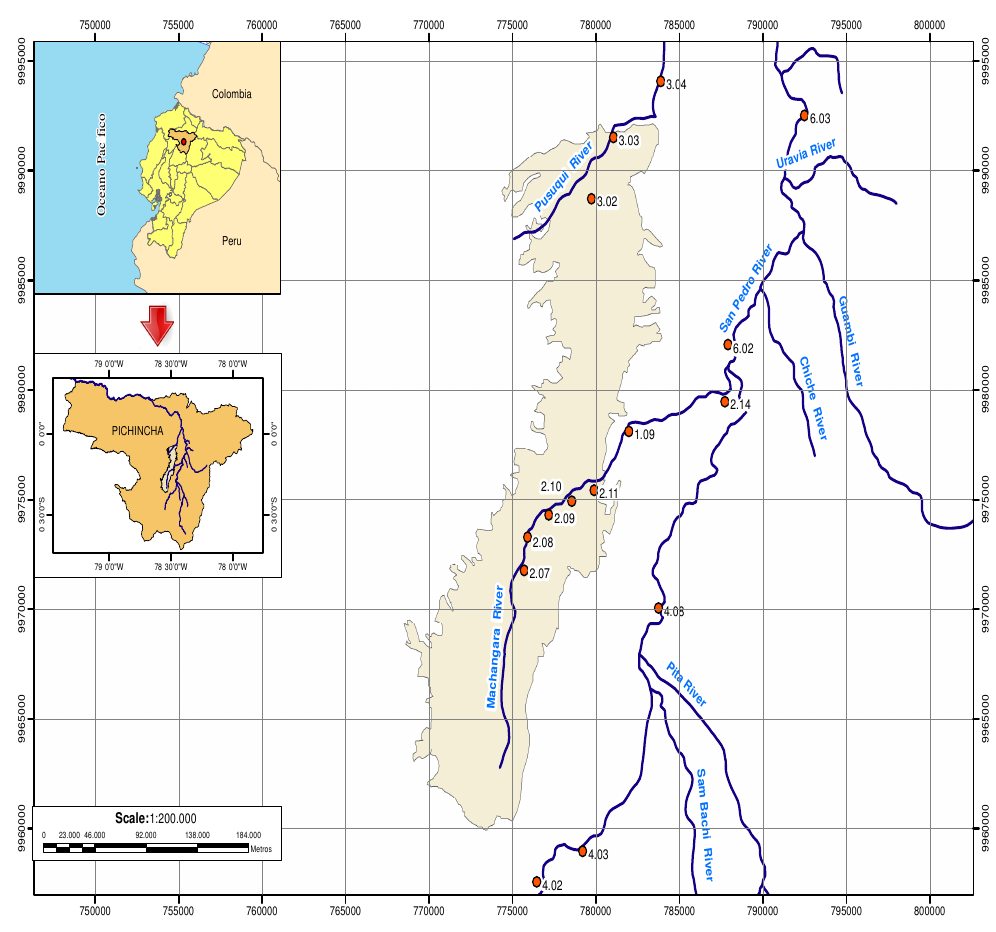
Figure 1. Monitoring station location at the Machángara River. The station name and numeric codes were provided by the Metropolitan Water Company of Quito, Ecuador.